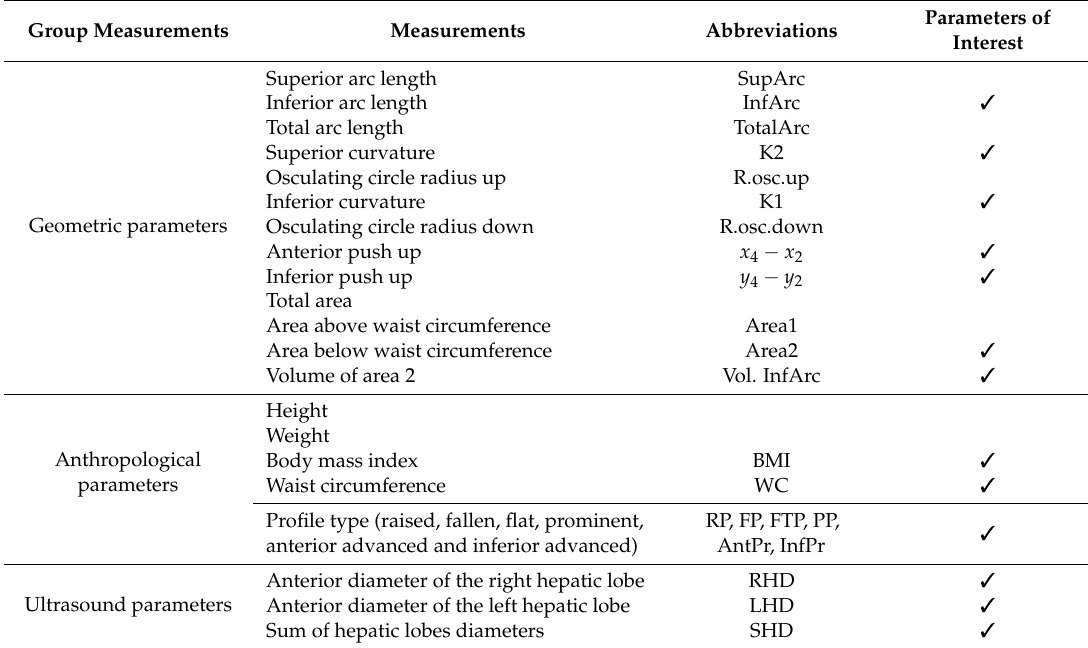
Table 1. The most important measured